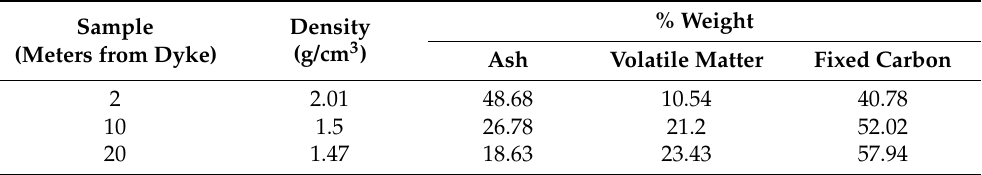
Table 1. Variation in raw coal properties in function of the distance from the dyke.